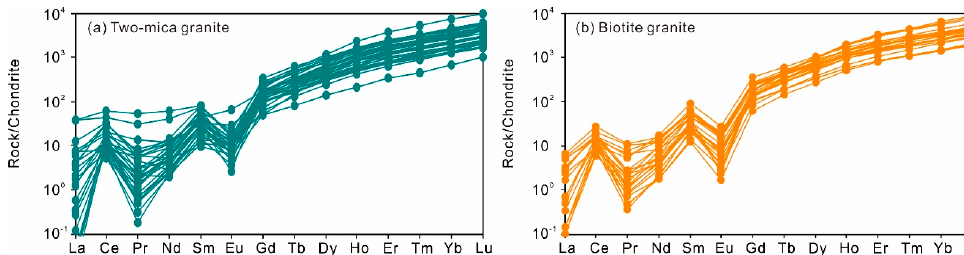
Figure 3. Chondrite-normalized [25] rare earth elements of zircons from the two-mica granite ( a ) and biotite granite ( b